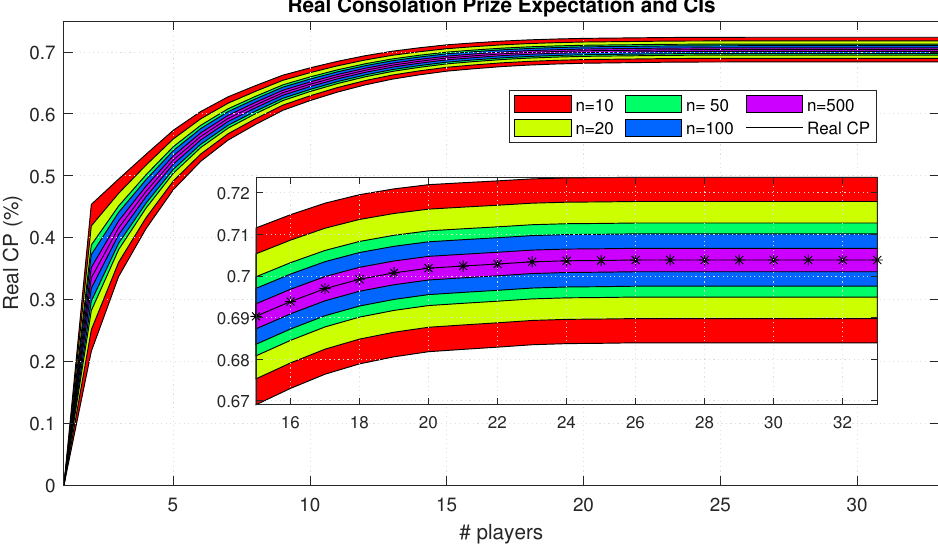
Figure 7. Real consolation prize expectation and CIs (first gaming